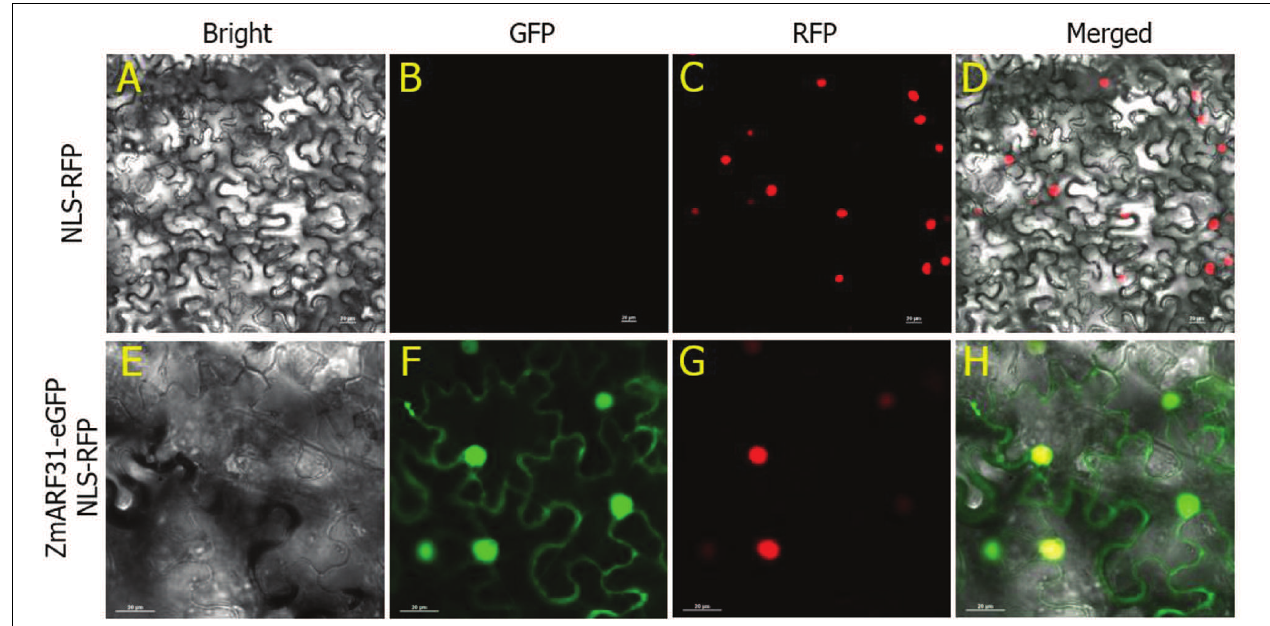
FIGURE 6 | Subcellular localization of the ZmARF31 protein in N. benthamiana leaves. NLS-RFP and ZmARF31-eGFP were driven by CaMV35S promoter and transiently expressed in N. benthamiana leaves. (A–D) Tobacco leaf transformed by CaMV35S:NLS-RFP as a control. (E–H) ZmARF31-eGFP targeted to the cell nucleus and cytoplasm in tobacco leaf. The images are shown in bright-field (A,E) , the GFP fluorescence (green) only (B,F) , the red fluorescent protein (RFP) fluorescence (red) only (C,G) , and merged (D,H) , respectively. Scale bars, 20 µ